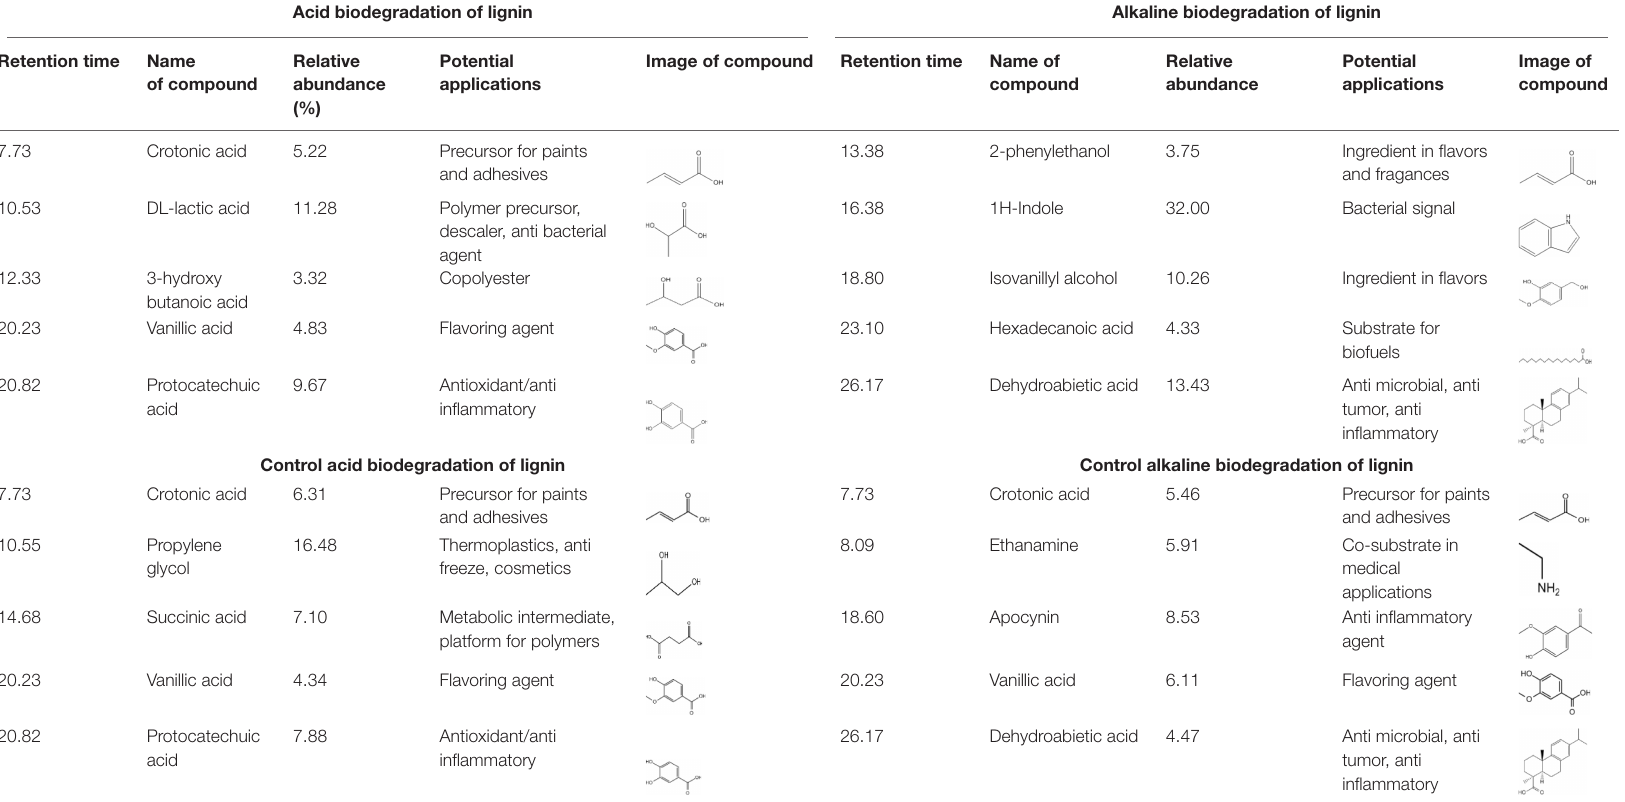
TABLE 1 | Summary of main degradation compounds from lignin degradation by E. coli BL21(Lacc) and controls. Acid biodegradation of lignin Alkaline biodegradation of lignin Retention